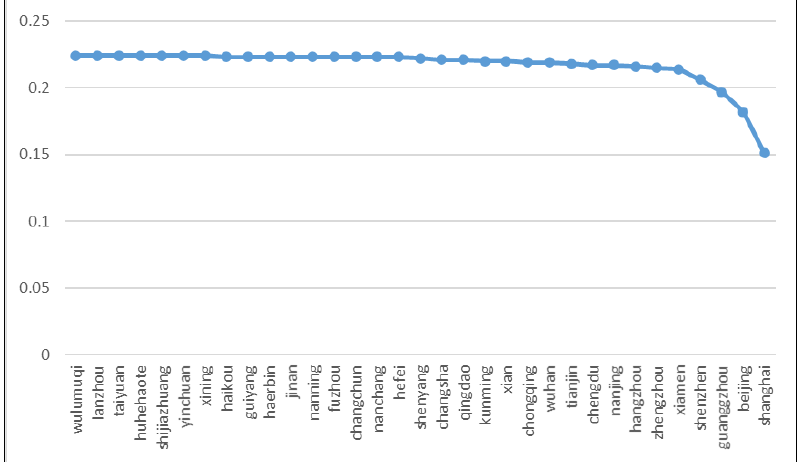
Figure 3. The direct effect of per capita GDP on cargo traffic in different regions.